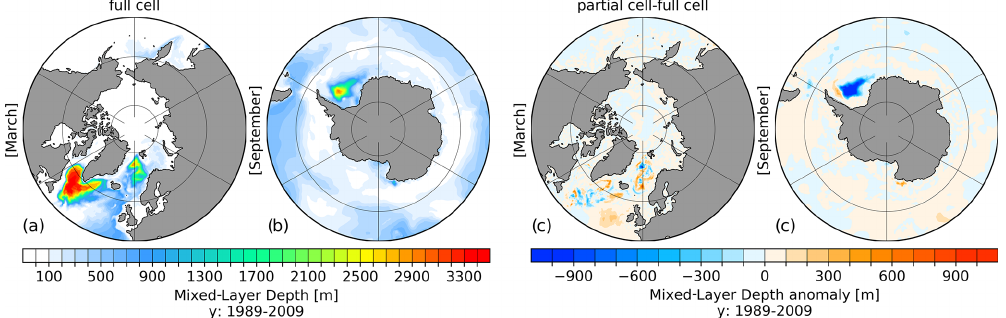
Figure 4. Northern Hemisphere March (a) and Southern Hemisphere September (b) mixed-layer depth (MLD) with full cells and corre- sponding anomalous MLD with partial minus full cells (c, d) averaged for the period 1989–2009.